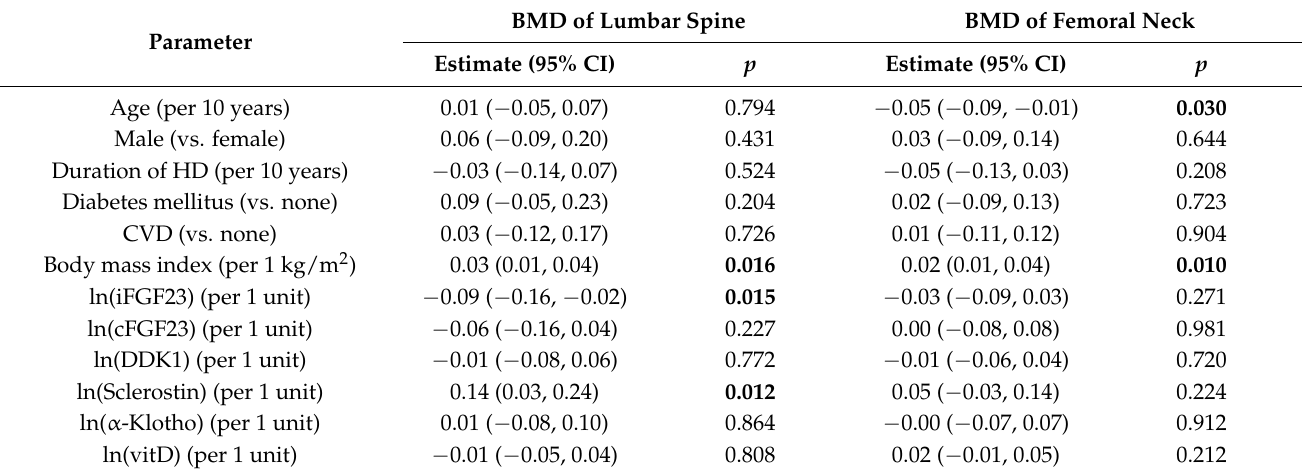
Table 2. Risk analysis of the bone mineral density in patients on chronic hemodialysis.